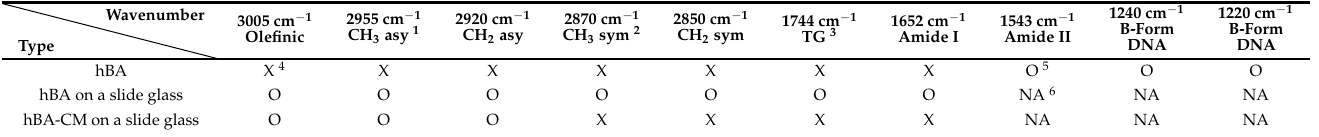
Table 3. Inclusion of important wavenumbers in the infrared region for each